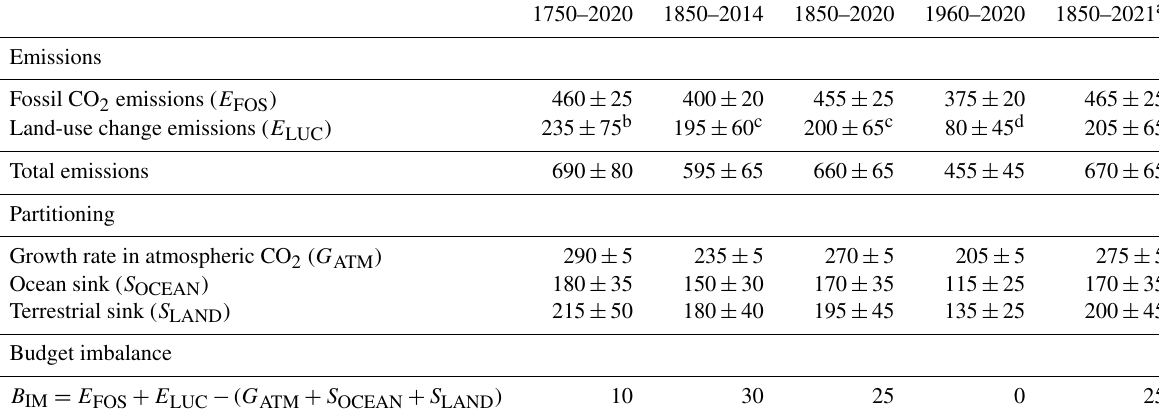
Table 8. Cumulative CO 2 for different time periods in gigatonnes of carbon (GtC). All uncertainties are reported as ± 1 σ . Fossil CO 2 emissions include cement carbonation. The budget imbalance ( B IM ) provides a measure of the discrepancies among the nearly independent estimates. All values are rounded to the nearest 5GtC and therefore columns do not necessarily add to